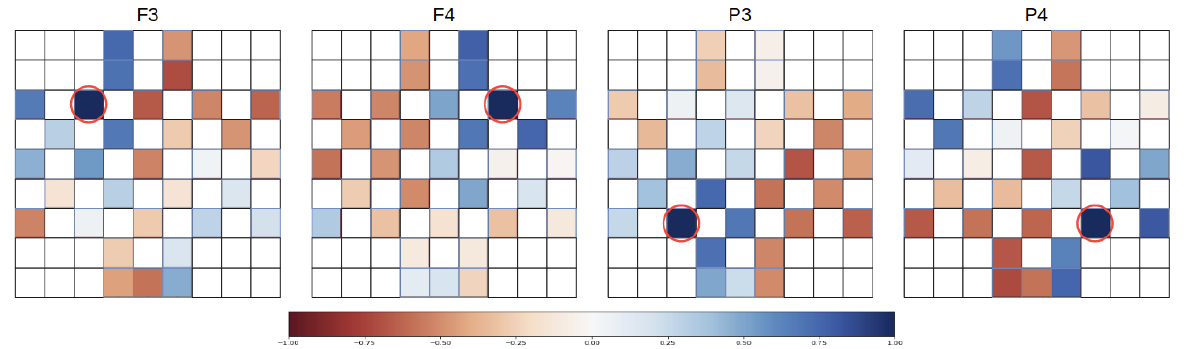
Figure 5. The Pearson correlation map between selected channels and the others. High positive correlation is presented as the dark blue color, and high negative correlation is presented as the dark red color. White means there is no correlation. The selected channels (F3, F4, P3, and P4) are marked with red circles.